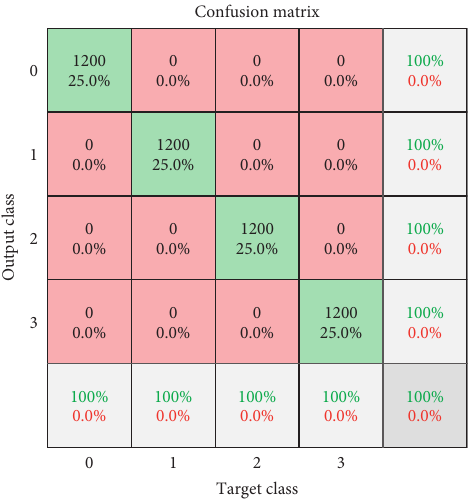
Figure 12: Confusion matrix of coarse class recognition using